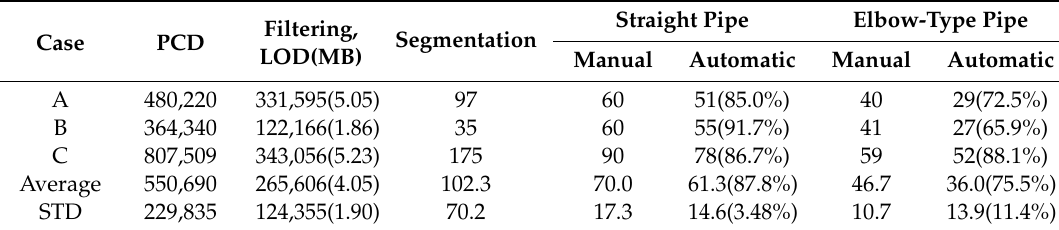
Table 6. Scan-to-BIM mapping pipeline performance (count, %).